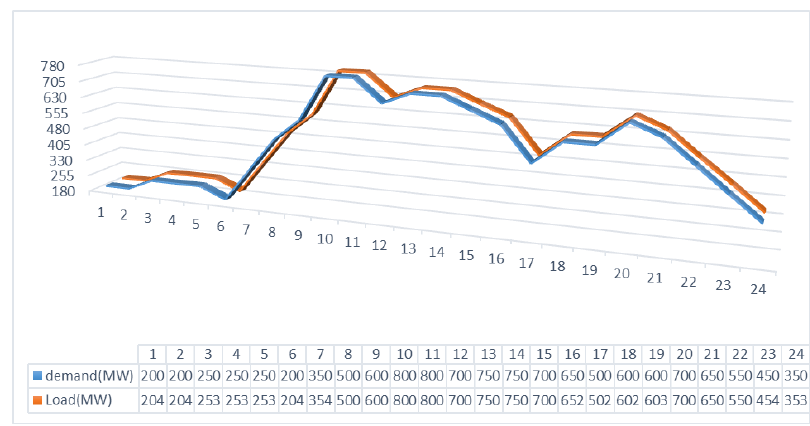
Figure 8. Load leveling for PEVs. Note: The PEVs is integrated as load for the whole day except from hour 8 till hour 15 and from hour 20 till hour 22.